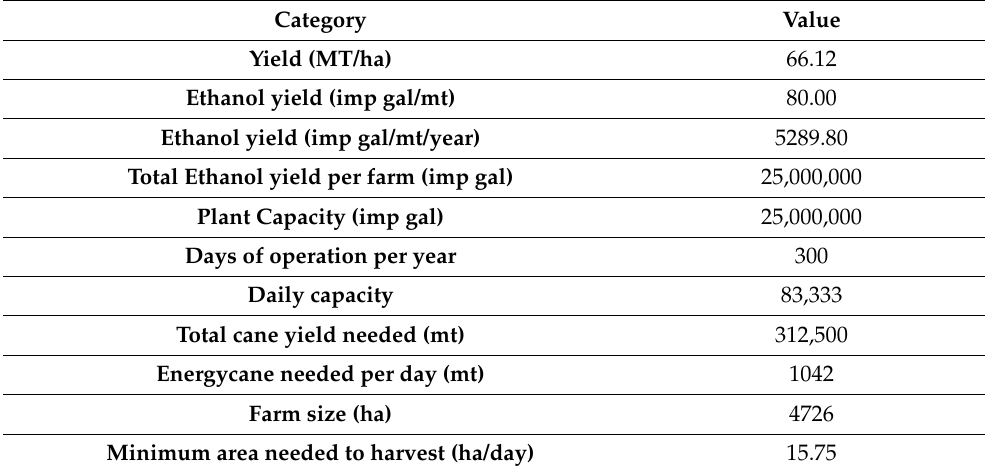
Table 1. Minimum area needed for daily harvesting for continuous supply of energycane for